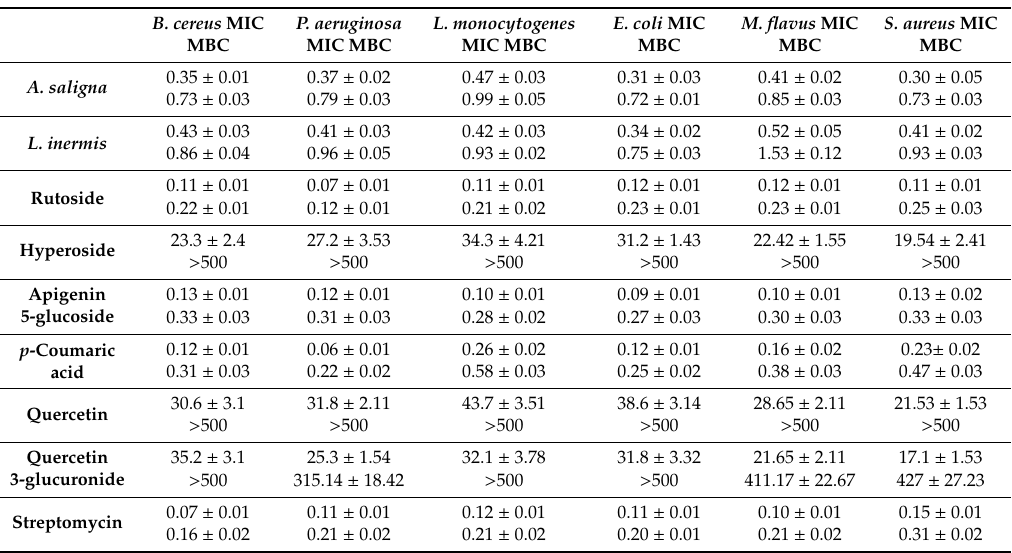
Table 2. Antibacterial effects of A. saligna and L. inermis methanolic extracts, rutoside, hyperoside and apigenin 5-glucoside, p- coumaric acid, quercetin and quercetin 3-glucuronide by means of minimum inhibitory (MIC) and bactericidal concentration (MBC) in mg/mL. Values are the means of three replicates .